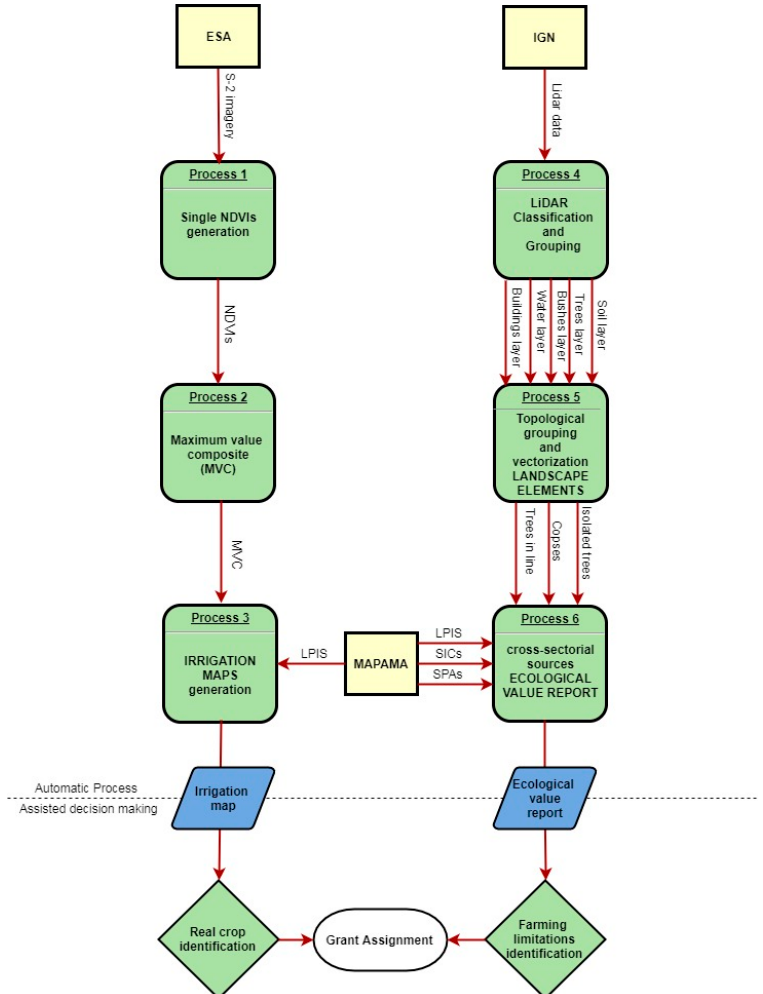
Figure 1. Data processing workflow: from original datasets to agricultural parameters’ definition. Squares represent sources of information. Rounded rectangles represent automatic processes. Parallelograms show outputs. Rhombuses represent decisions. The white shape tells where the flowchart ends. LPIS, Land Parcel Identification System; SPA, Special Protection Area for Birds; MAPAMA, Spanish Environment and Agriculture Ministry; IGN, Spanish National Geographic Institute; SIC, Site of Community Interest.